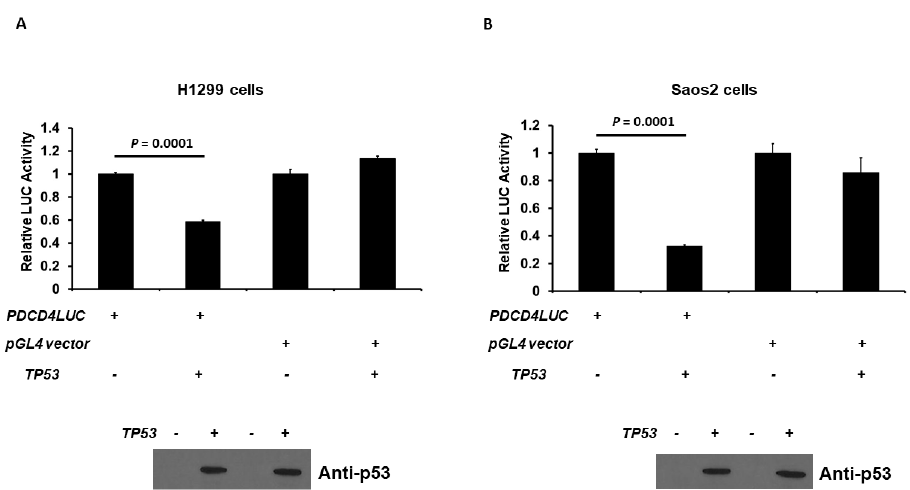
Figure 2. p53 down-regulates PDCD4 transcription. p53 reduces PDCD4 promoter activity in H1299 ( A ) and Saos2 ( B ) cells. Cells in a 24-well plate were co-transfected with either PDCD4 luciferase reporter plasmid or pGL4 empty vector and pRL-TK Renilla control vector, with or without p53 ex- pression plasmids, by Fugene HD. After forty-eight hours of transfection, luciferase activities were analyzed by the Dual-Luciferase Reporter System and normalized to the control Renilla activity. Relative LUC activity was calculated and plotted. The protein levels of p53 in the cells from the reporter assays were confirmed using anti-p53 immunoblotting. The original WB can be found in Supplementary Material.